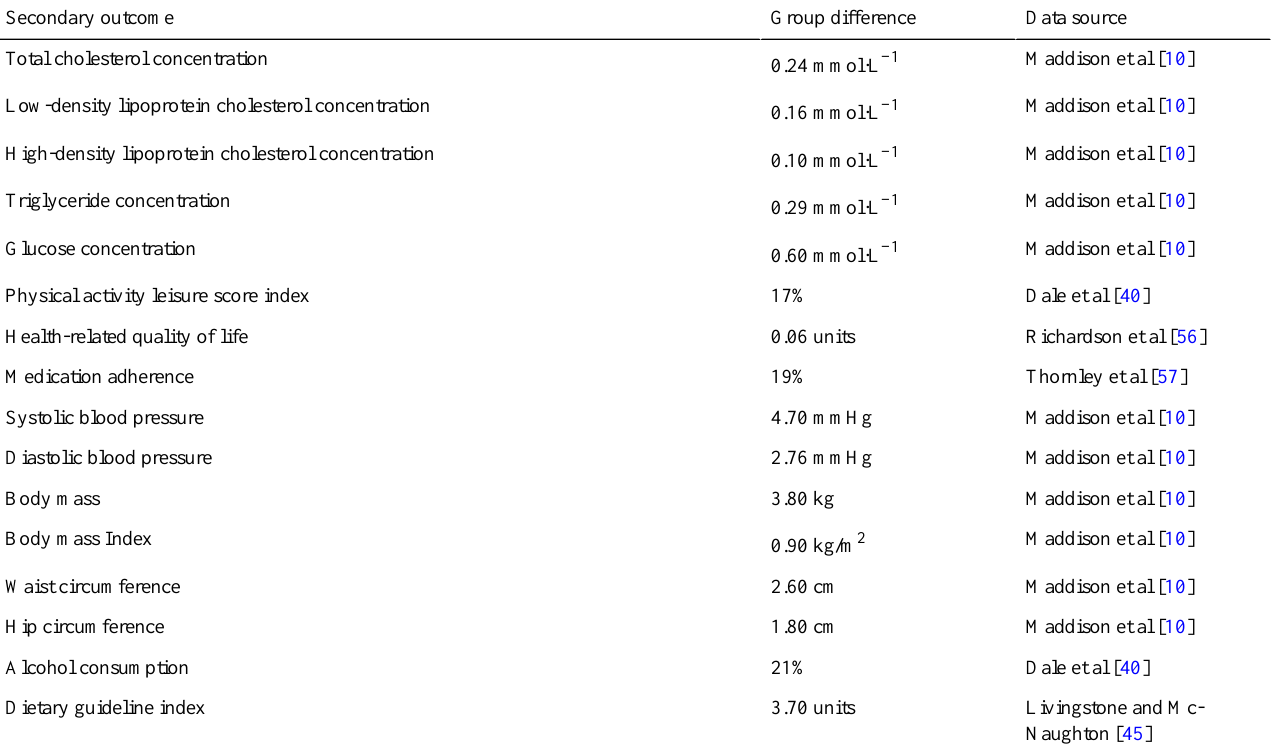
Data sourceGroup differenceSecondary